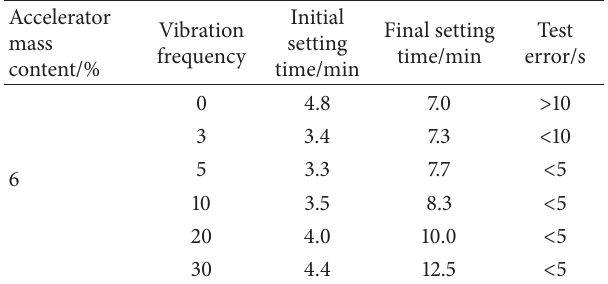
Table 4: Effect of vibration frequency on setting time under the same test